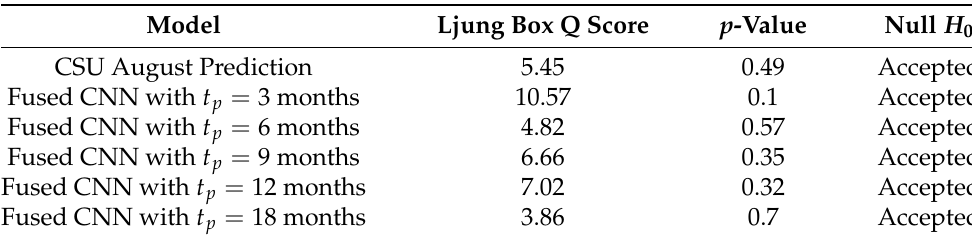
Table 3. Prediction reliability metrics over the Test set (2012–2018) for different prediction windows with significance level of